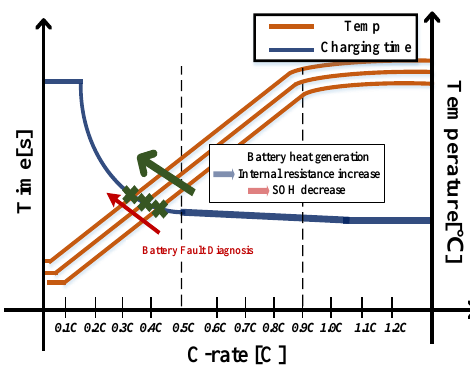
Figure 11. Battery charge time and temperature increase graph.